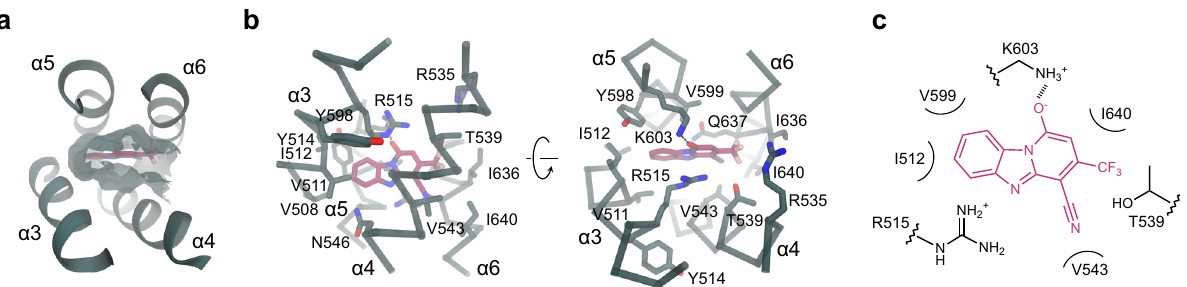
Fig. 4 1PBC binding site. a Position of 1PBC in the binding pocket viewed from the extracellular side. Molecular boundaries are represented as green surface. b Detailed view of residues in contact distance to 1PBC. A putative salt bridge between Lys 603 and the 1PBC hydroxyl is indicated. c Schematic contact map between 1PBC and selected surrounding